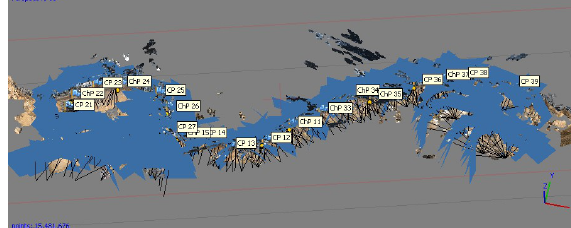
Figure 3. Imaging locations, CPs and ChPs of the